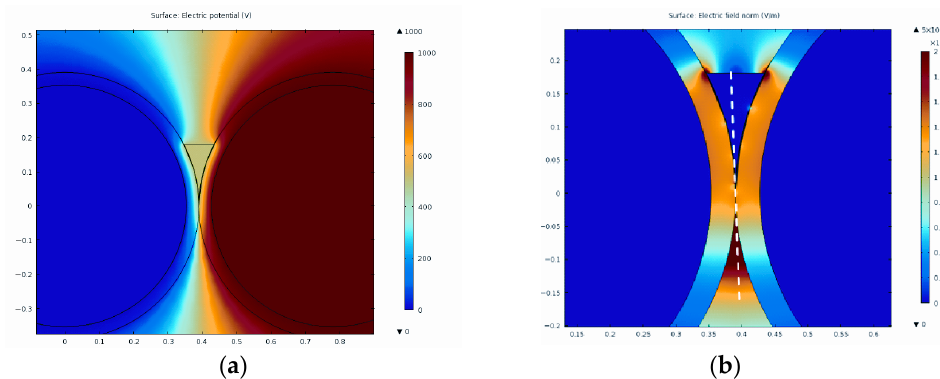
Figure 15. Visualization of the ionization zone and variable surface conductivity area.